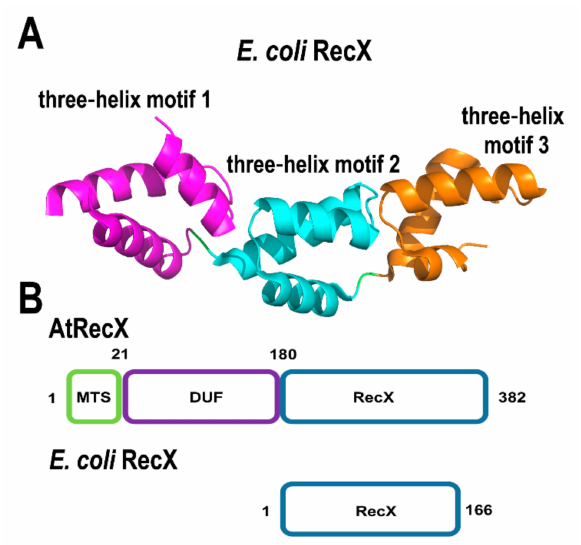
Figure 5. Structural organization of AtRecX. ( A ) Crystal structure of RecX from E. coli (PDB: 3c1d). RecX is composed of three repeats of a three-helix motifs, ( B ) modular organization of AtRecX in comparison to bacterial RecX. Plant RecX harbor a mitochondrial targeting sequence (MTS) and a N-terminal domain of unkown function. AtRecX share more than 30% amino acid identity with bacterial